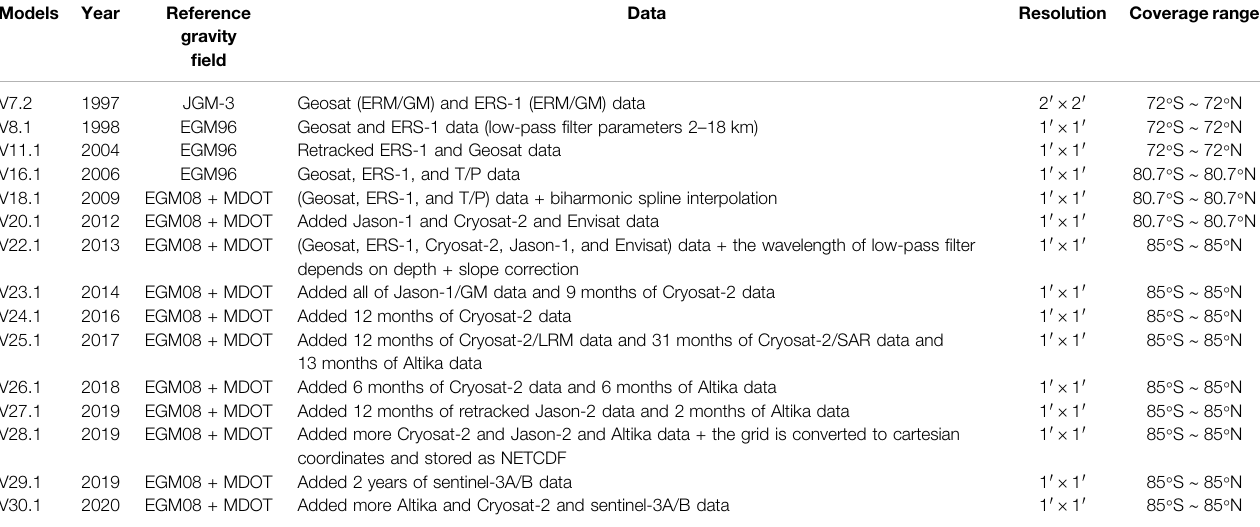
TABLE 1 | Introduction of partial S&S series global marine gravity fi eld